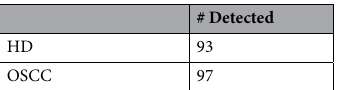
Table 4. Average number of miRNAs, out of 134 from the classifier, detected in the plasma of healthy subjects and patients. HD, healthy donors. OSCC, patients with OSCC. # Detected, average number of miRNAs detected in the